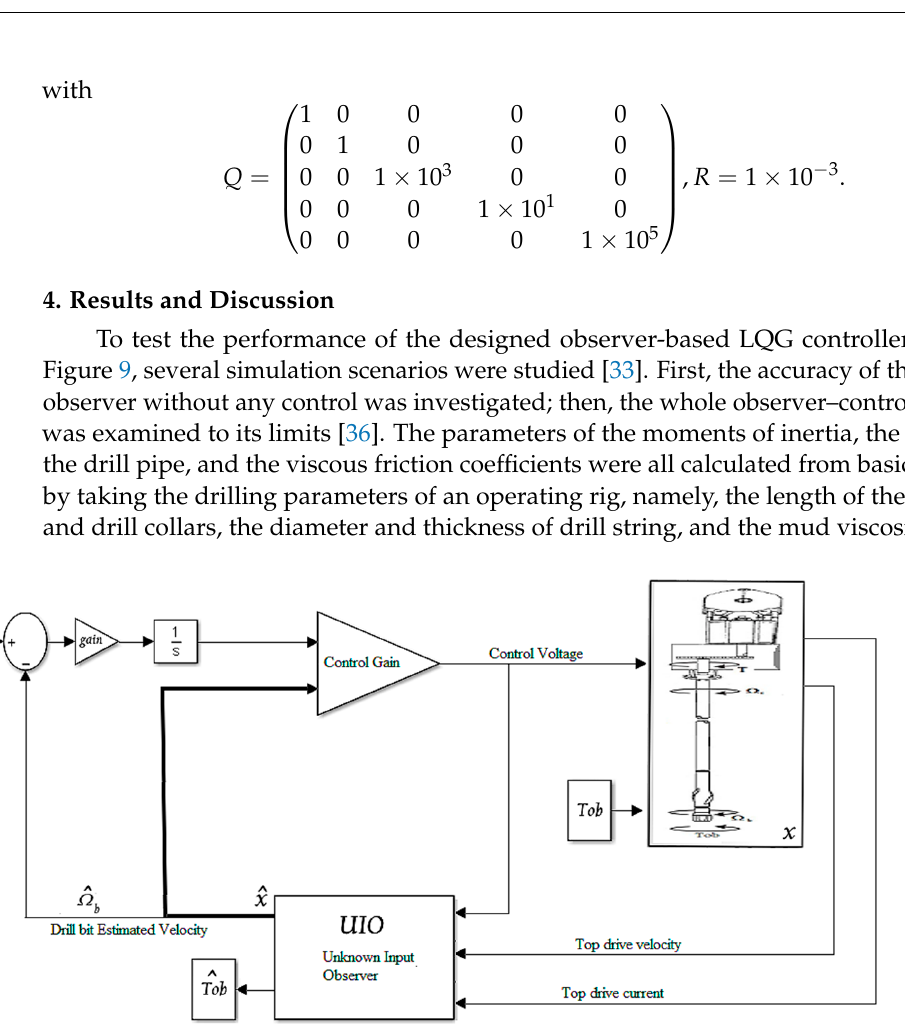
Figure 9. LQG observer-based controller block for drill string system.